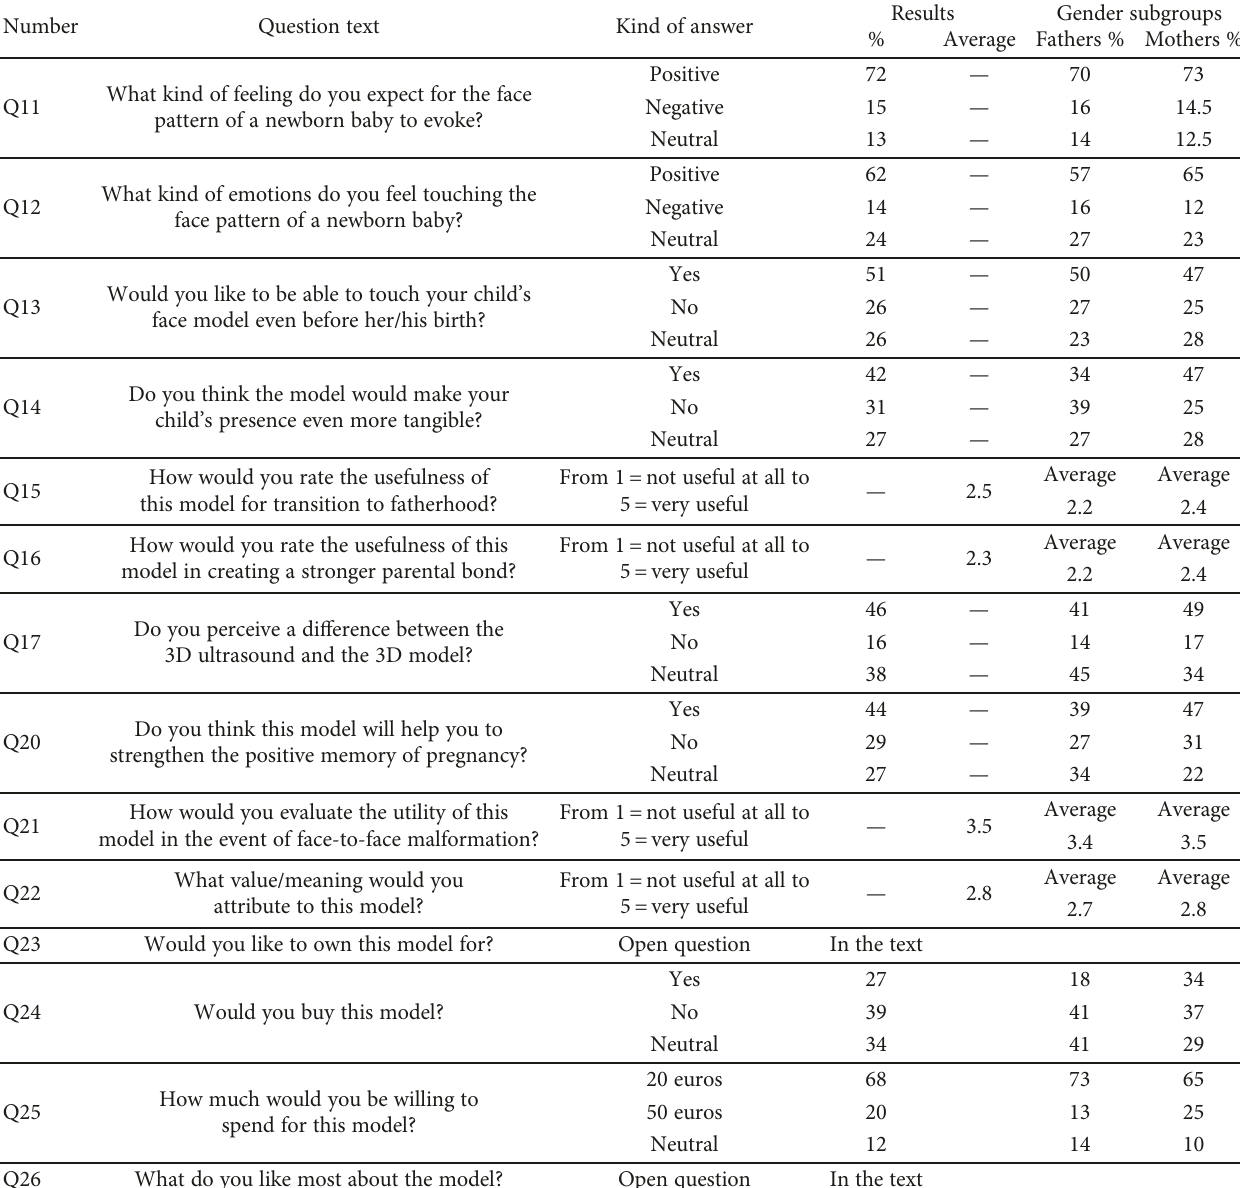
Table 4: Relevant questions concerning the perception of emotions and tactile sensations evoked by the 3D model. Number Question text What kind of feeling do you expect for the face Q11 pattern of a newborn baby to evoke?